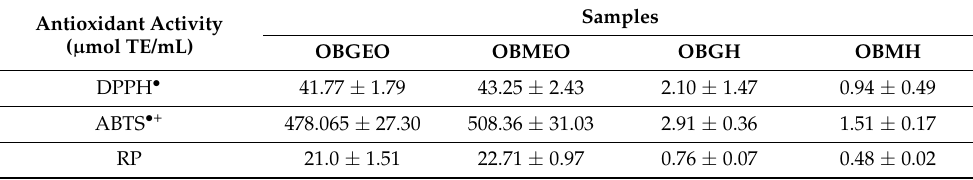
Table 2. In vitro antioxidant activity of O. basilicum essential oils and hydrolates. Antioxidant Activity ( µ mol TE/mL)